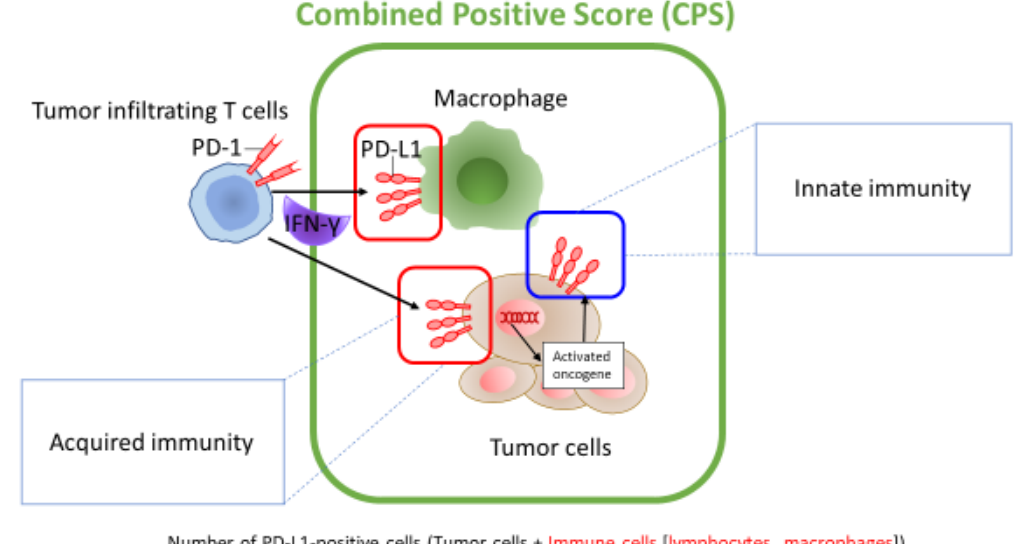
Figure 2. Mechanisms for PD-L1 expression and definition of combined positive score (CPS). Citations and modifications of Nat Rev Cancer. 2016 , 16, 275–287. Innate expression of membranous PD-L1 by tumor cells is thought to be driven by dysregulated signaling pathways, or chromosomal alterations and amplifications. In contrast, adaptive focal expression of PD-L1 by tumor cells and macrophages occurs at the interface of tumor cell nests with immune infiltrates secreting pro-inflammatory factors such as interferon- γ . The ligation of PD-L1 with PD-1 molecules will down-modulate T cell function, essentially creating a negative feedback loop that dampens antitumor immunity [37].